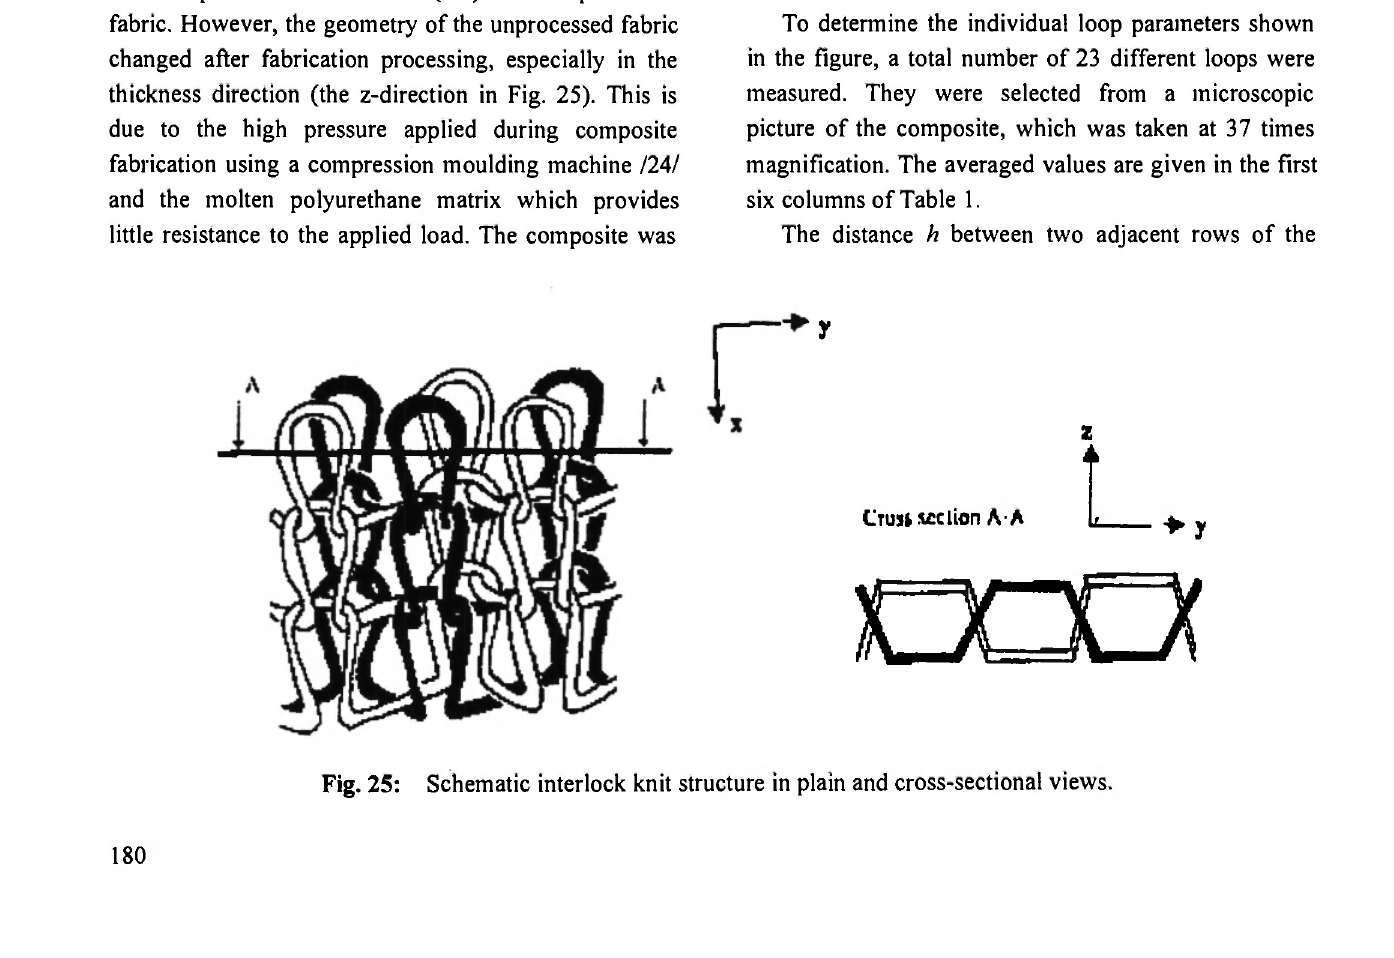
Fig. 26: Loop geometry and assigned parameters.